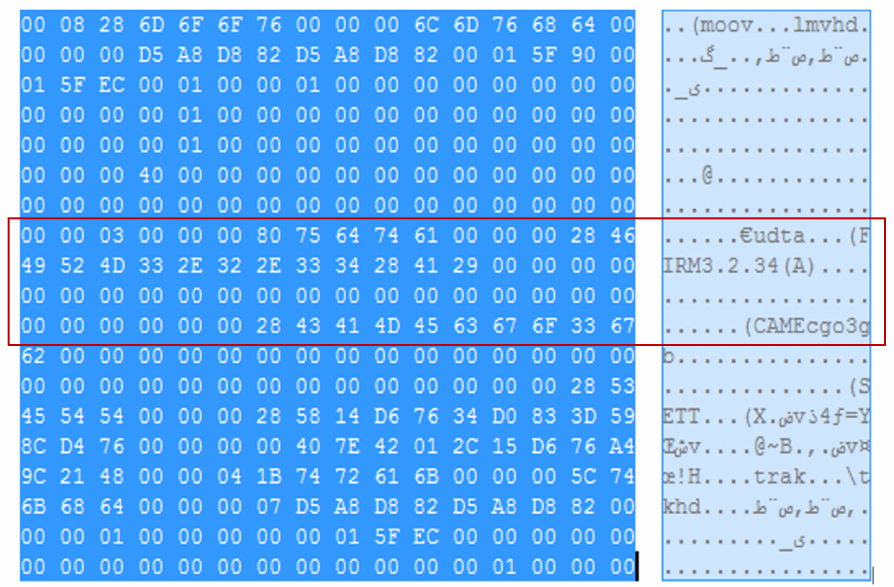
Figure 6. Content of “udta” box.